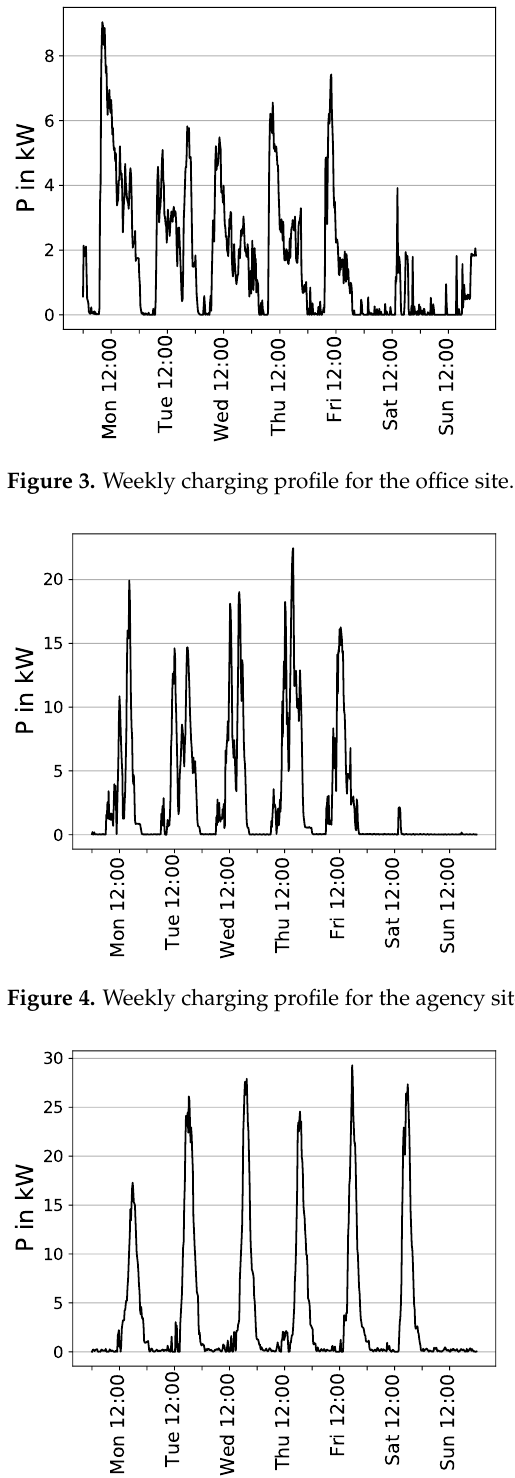
Figure 5. Weekly charging profile for the logistics